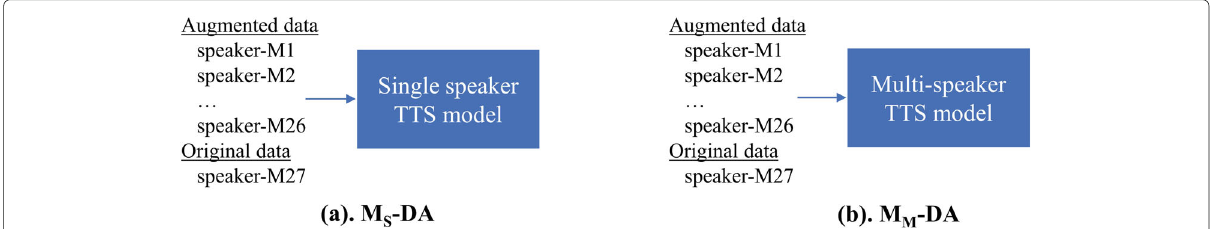
Fig. 6 Method used to train TTS models with augmented target language data, where a is a single-speaker model and b is a multi-speaker